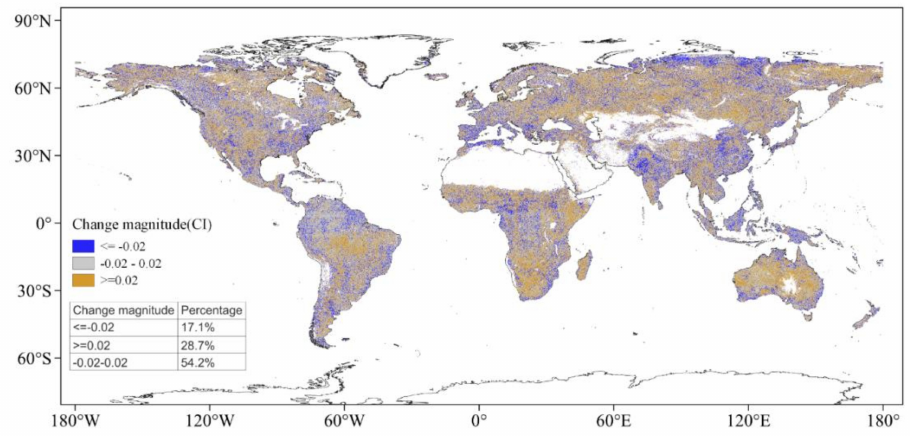
Figure 5. Change magnitude of CI between the two dates of the detected trend segment during the entire period (2000–2020). The attached table shows the percentage of number of